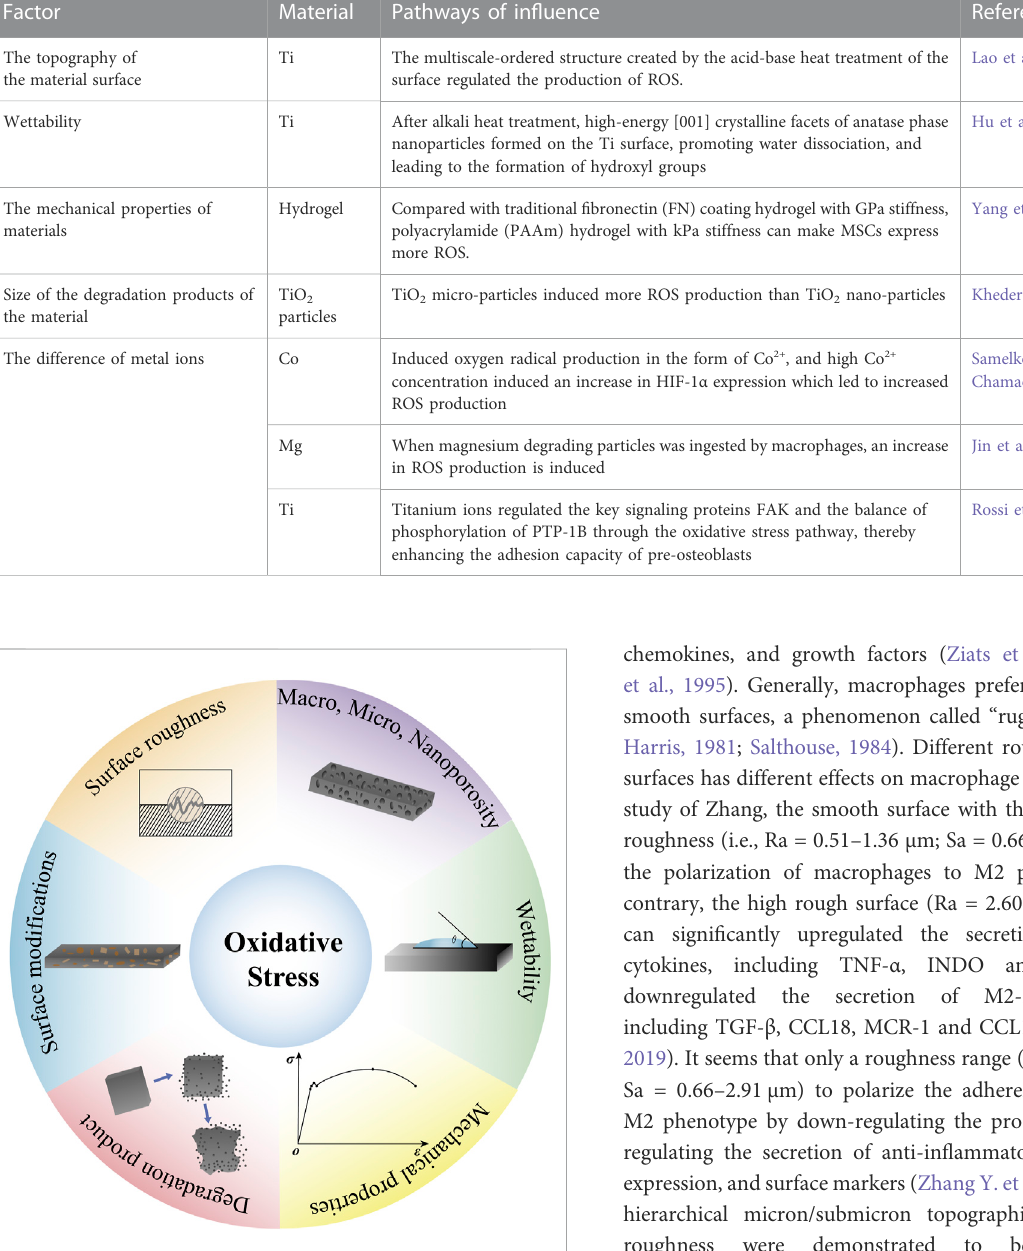
FIGURE 1 Material factors affecting oxidative stress. Materials factors such as, the size and shape of materials, the morphology, wettability, mechanical properties, and other properties play a signi fi cant role in oxidative